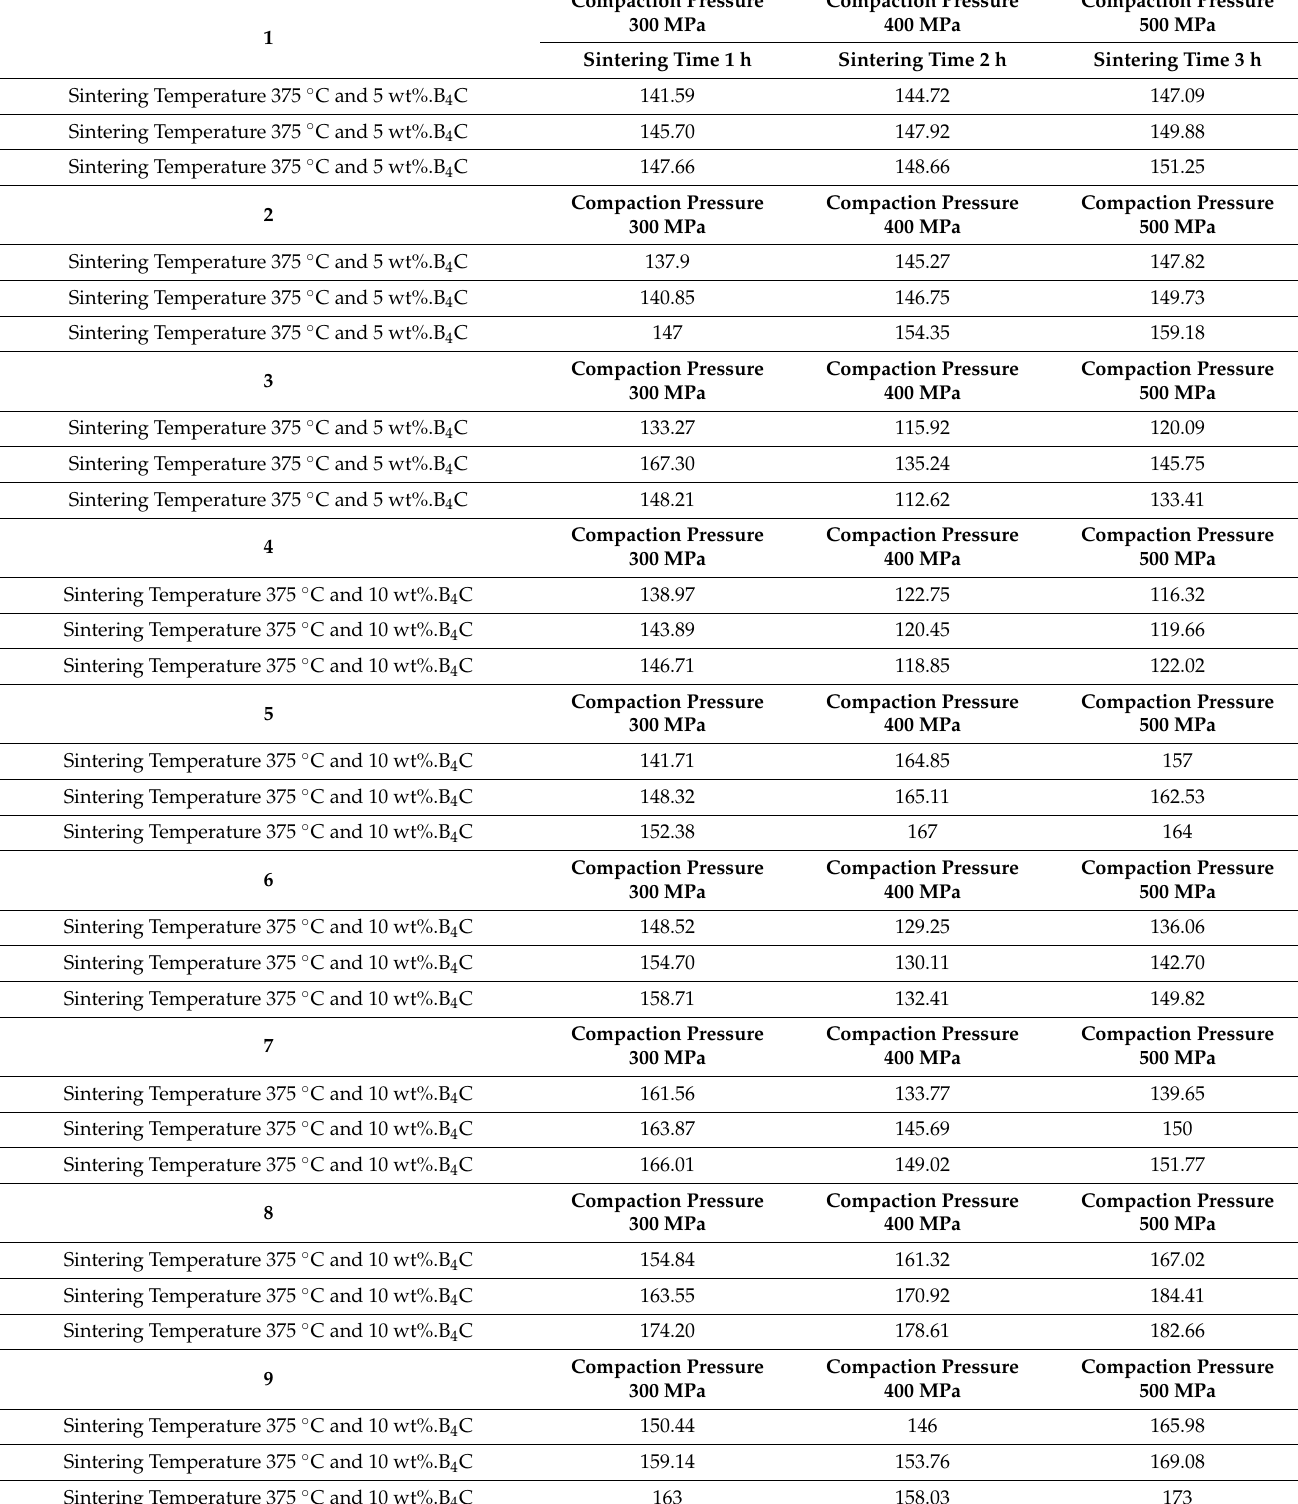
Table 2. Effect of PM parameters on micro hardness at different compaction pressure (300, 400, and 500 MPa), different sintering time (1, 2, and 3 h), different sintering temperature (375, 475, and 575 ◦ C), and different reinforcement weight percentages (5 wt%., 10 wt%., and 15 wt%.B 4